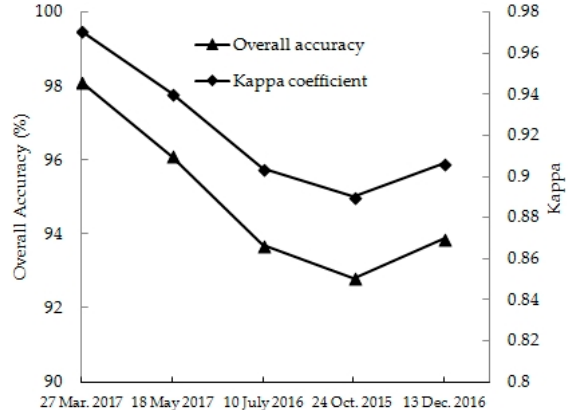
Figure 3. Overall classification accuracies and Kappa coefficients for land cover classification from five single seasonal images using the five predictive variable selection datasets listed in Table 4.